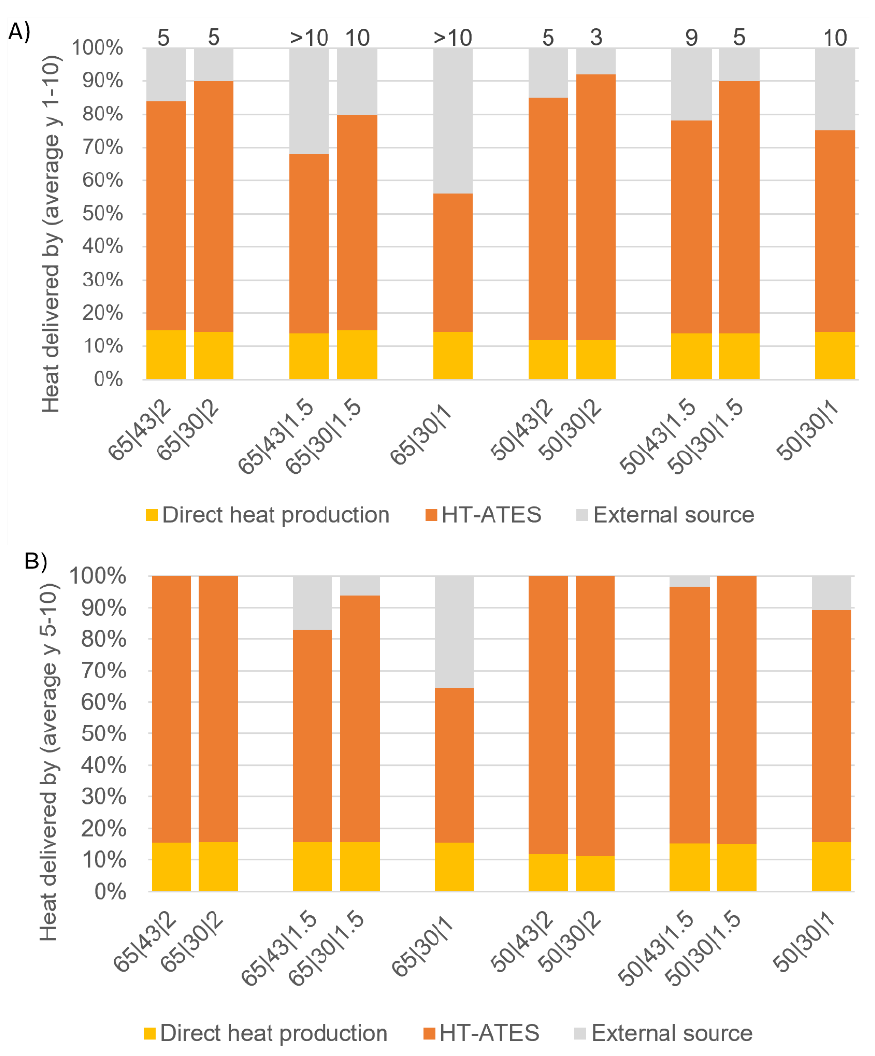
Figure 4. Stacked bar plots of the distribution of heat delivery from direct production of heat and from the HT-ATES system. In grey, the amount of heat that cannot be fulfilled by the heat pump and HT-ATES system is shown. The left plot ( A ) shows the distribution for the first ten years of operation. The numbers on top of the bars indicate the number of years when full heat delivery from the heat pump-HT-ATES system is reached, with no external source requirement. The right plot ( B ) shows the distribution of heat delivery for the last five years of operation, with five scenarios fully able to fulfil the heat demand.